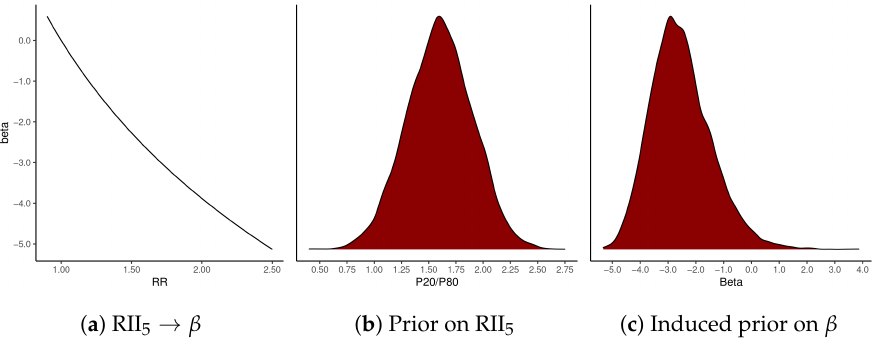
Figure 10. The prior probability model for β , the ICE-mortality gradient. RII 5 is the p 20/ p 80 mortality rate ratio, with counties ordered by their ICE.